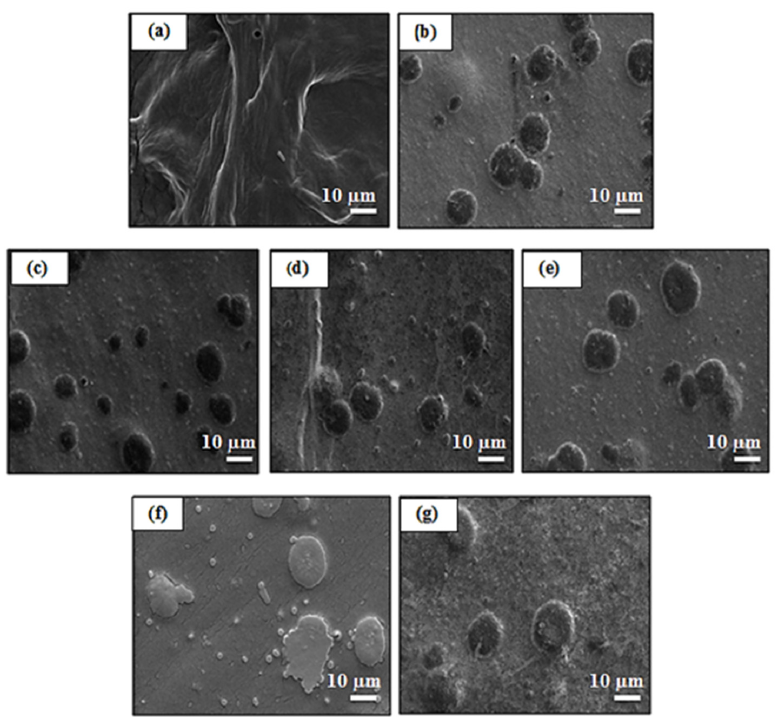
Figure 2. VPSEM surface micrograph at 1000 × magnification of ( a ) pure GG film, ( b ) GG-Carv 01, ( c ) GG-Carv 02, ( d ) GG-Carv 04, ( e ) GG-Carv 08, ( f ) GG-Carv 16 and ( g ) GG-Carv